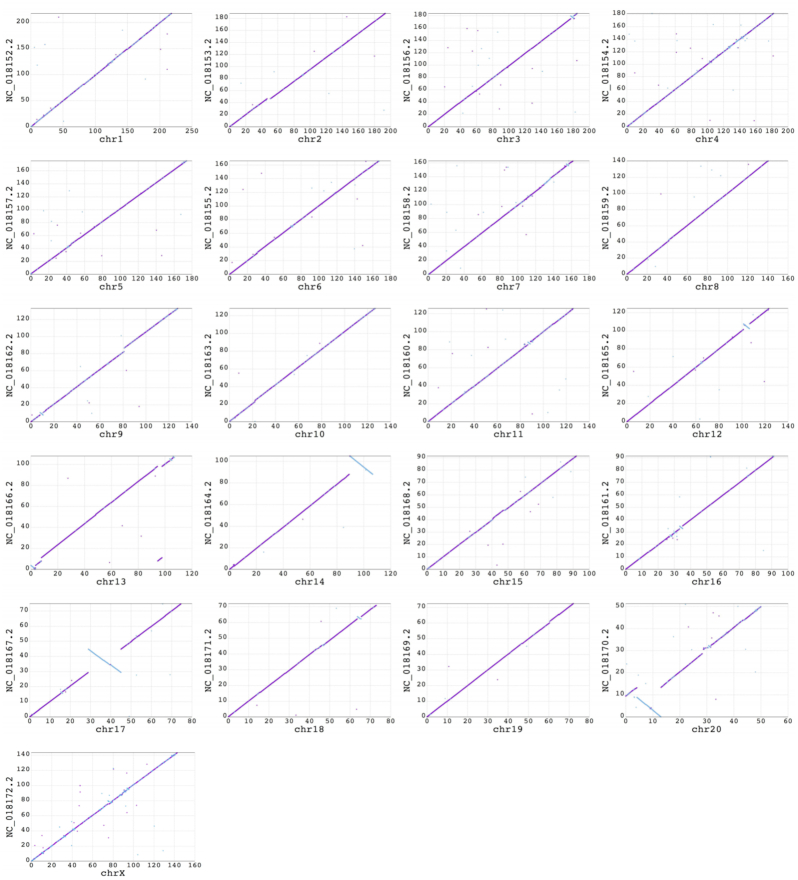
Dot plots showing alignment of Panu_3.0 reference-assisted chromosomes vs Panubis1.0 chromosome-length scaffolds. The Panu_3.0 assembly is shown on the Y-axis and the Panubis1.0 assembly is shown on the X-axis. Each dot represents the position of a syntenic block between the 2 assemblies as determined by the nucmer alignment. The color of the dot reflects the orientation of the individual alignments (purple indicates consistent orientation and blue indicates inconsistent orientation). The dot plots illustrate that there are chromosomes containing large inversions and translocations in the Panu_3.0 assembly with respect to the Panubis1.0 assembly.